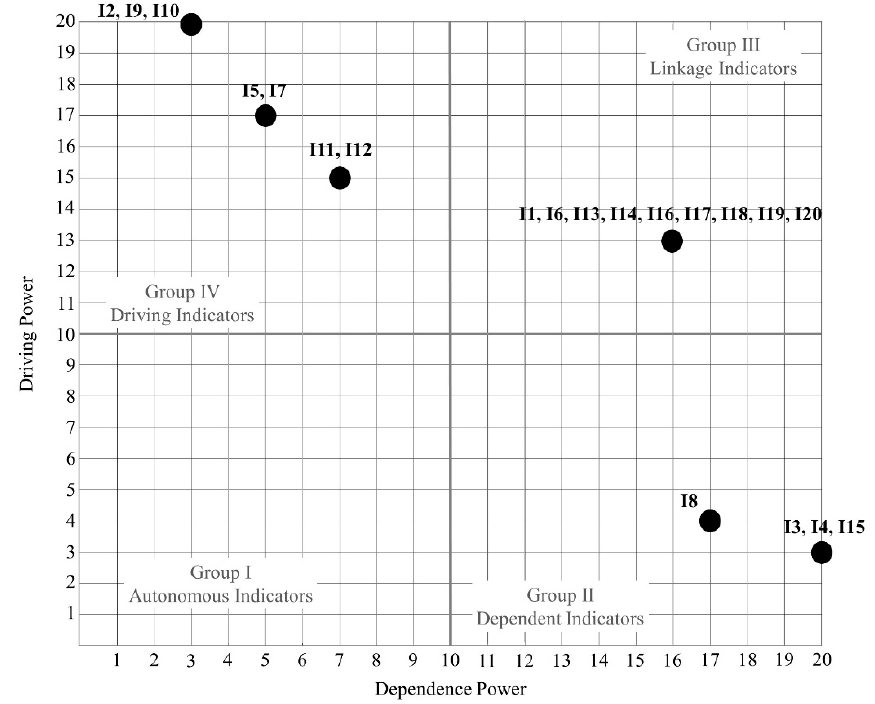
Figure 3. MICMAC